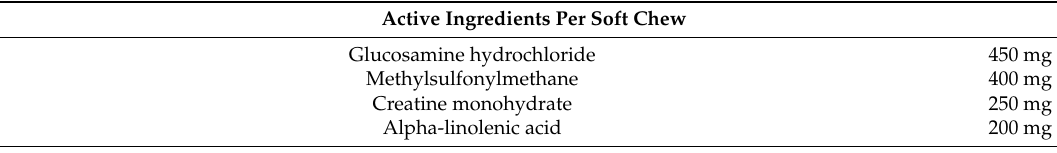
Table 1. Phycox ® soft chew formula for canines (Pieloch 2006) (Phycox ® active ingredient is a proprietary blue-green algae